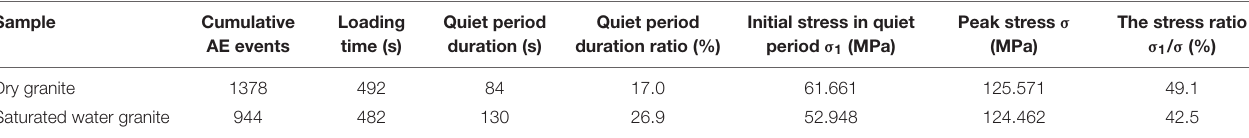
FIGURE 8 | Damage evolution of granite on time and strain scales under uniaxial compression in water state. Divides the different stages of the uniaxial compression process according to the AE characteristics and stress-strain. TABLE 1 | comparison of AE event characteristics between dry and saturated water